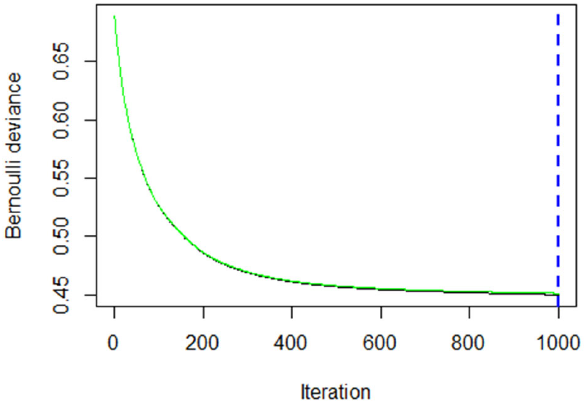
Figure 10. Overfitting test